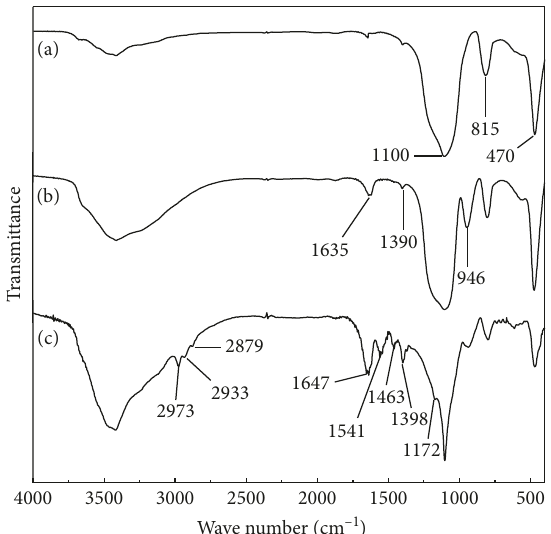
Figure 3: The FTIR spectra of (a) SiO SiO 2